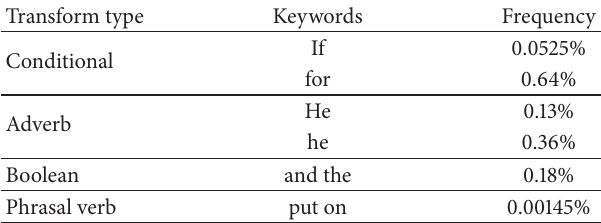
Table 8: Examples of keyword